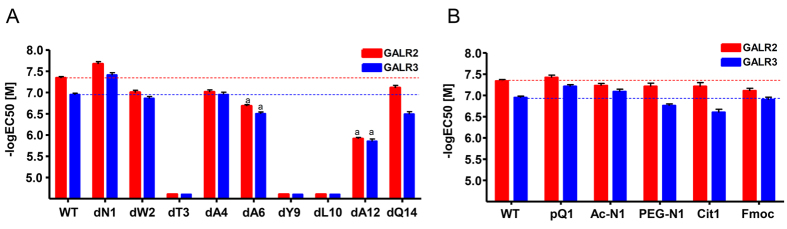
Effect of single D-amino acid substitution (A) and Asn1 replacement/modification (B) on the potency toward GALR2 and GALR3. The SRE-luc reporter vector and plasmid containing human GALR2 or GALR3 were transfected into HEK293 cells that stably expressed Gqi protein. Cells were then treated with increasing concentrations of mutant peptides, and the receptor activities were determined using the SRE-luc reporter system. Potencies of mutant peptides toward the GALR2 (red bars) and GALR3 (blue bars) by the mutant peptides are expressed as −log[EC50] values. The horizontal dashed lines represent potency of WT SPX toward receptors. a, P < 0.05 vs. WT SPX